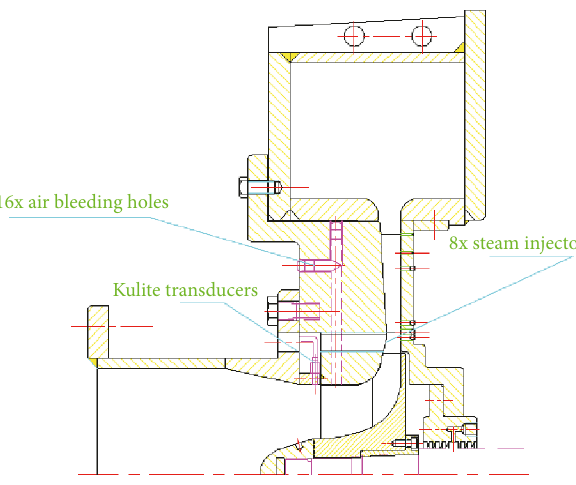
Figure 2: Cross-sectional view of the test section.